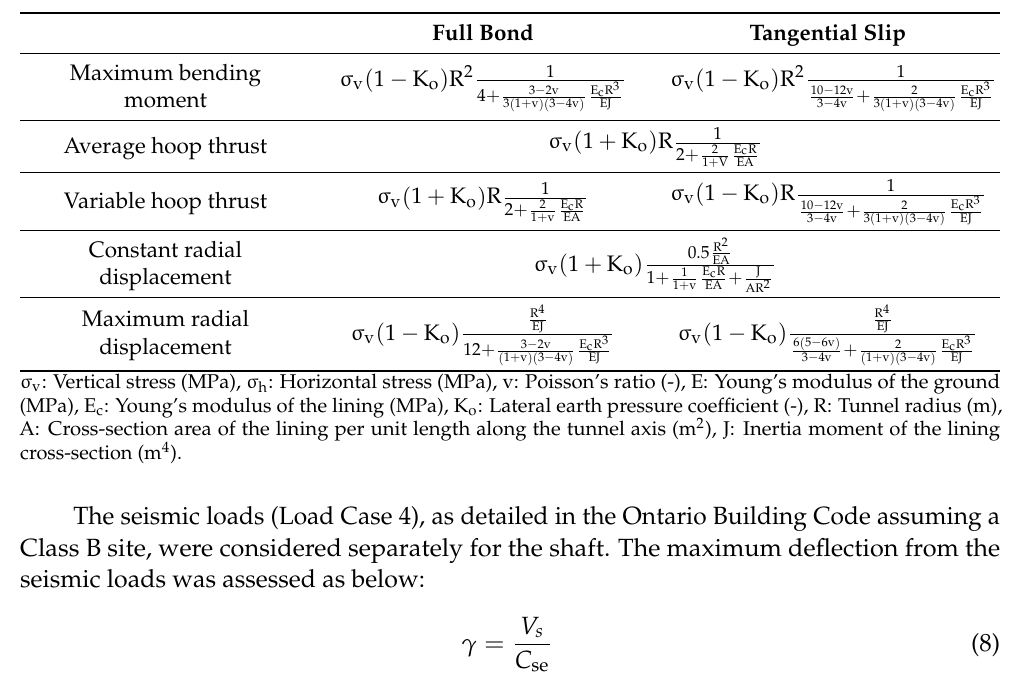
Table 4. Duddeck and Erdmann